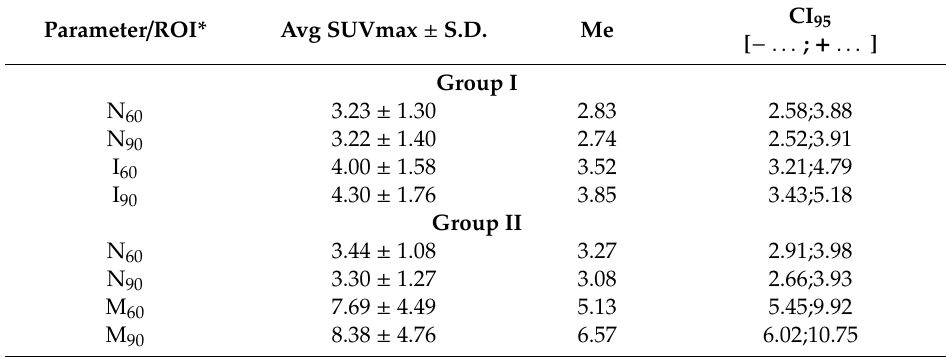
Table 3. The SUVmax values at 60 and 90 min p.i. of the 18 F-FDG. Parameter / ROI*